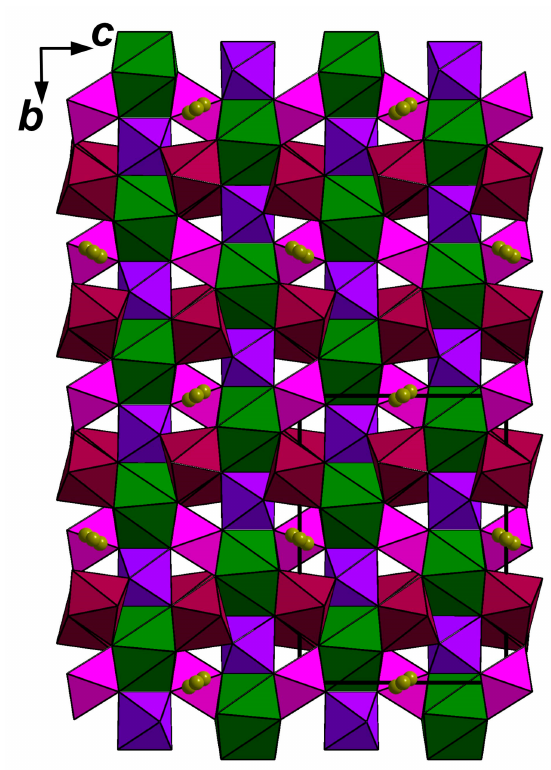
Figure 5. The crystal structure of nöggerathite-(Ce). The unit cell is outlined. For legend see Figure